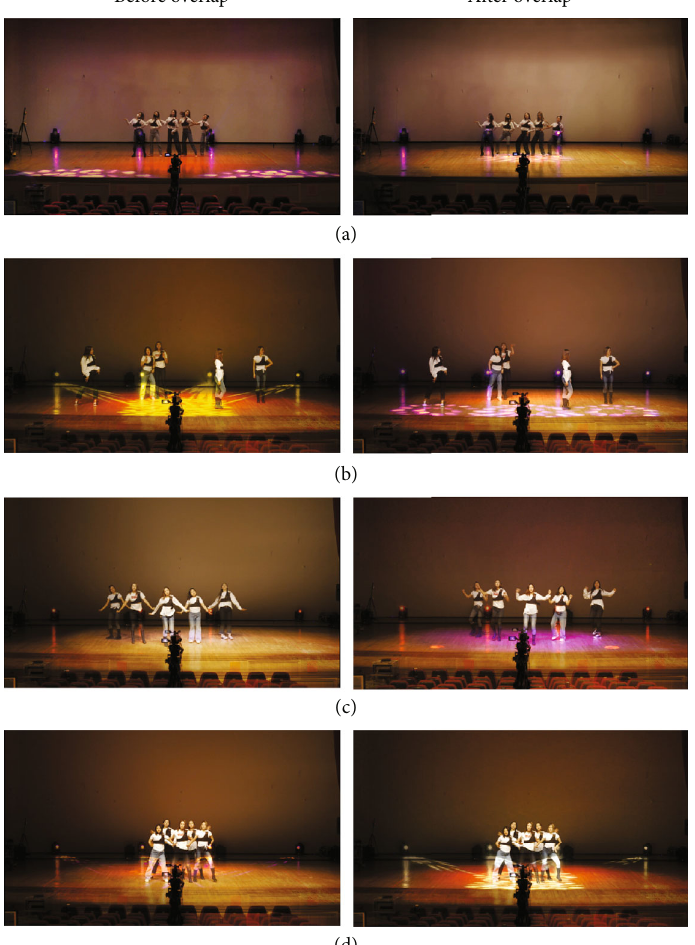
Figure 12: A captured image of a lighting e ff ect comparison video modi fi ed using the existing lighting e ff ect and overlapping